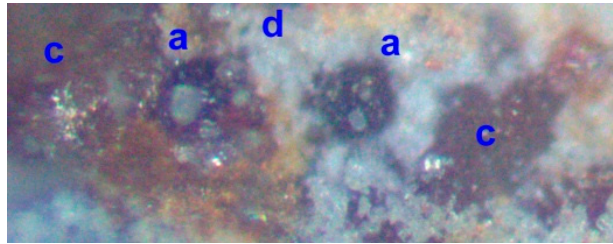
Figure 12. (ST2a Trial [16]) ZVI Product. ( a ) = ferrate (Na z FeO x (OH) y ) nodule containing rounded halite nodules. ( c ) = goethite; ( d ) = halite crystals (white) infilling porosity. Field of view = 0.133 mm. Reflected light.